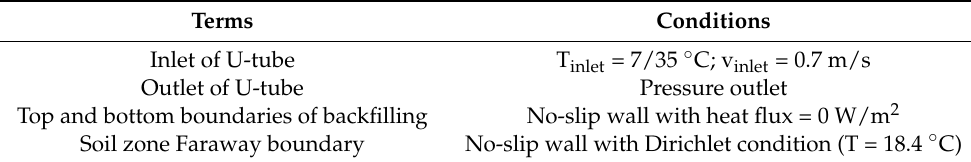
Table 3. Boundary and simulation